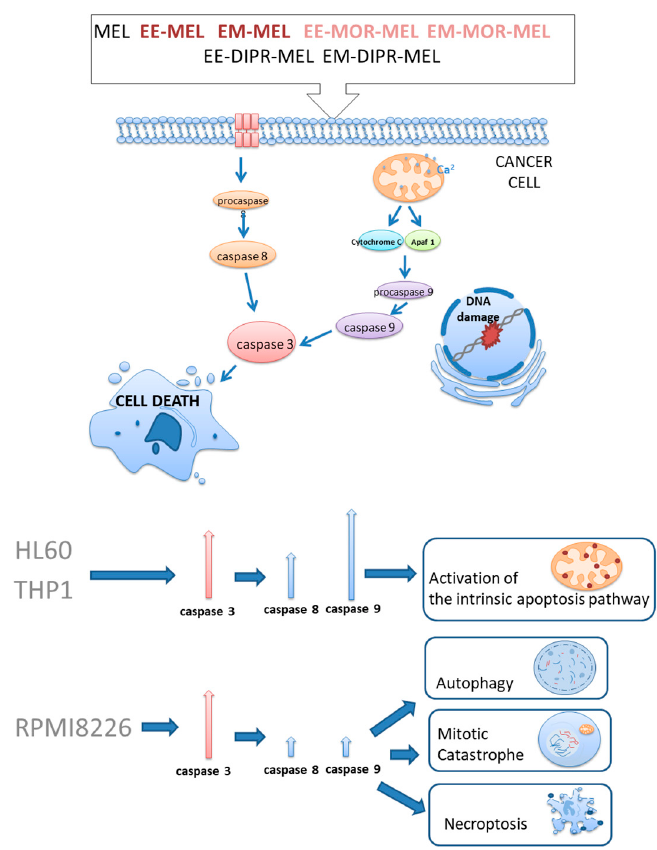
Figure 2. Mechanism of action of melphalan and new derivatives of melphalan. The cellular response to the test compounds varied depending on the cell type. Melphalan and its analogues activate the intrinsic pathway of apoptosis in acute monocytic leukemia cells and promyelocytic leukemia cells. In MM cells, these compounds activate mechanisms of cell death other than apoptosis, such as mitotic disaster, autophagy, or necroptosis. Figure is adapted from previous publication [142].